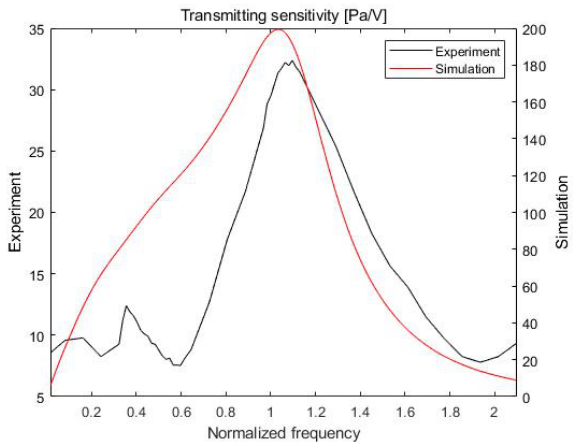
Figure 6. Transmitting sensitivity of the proposed actuator.